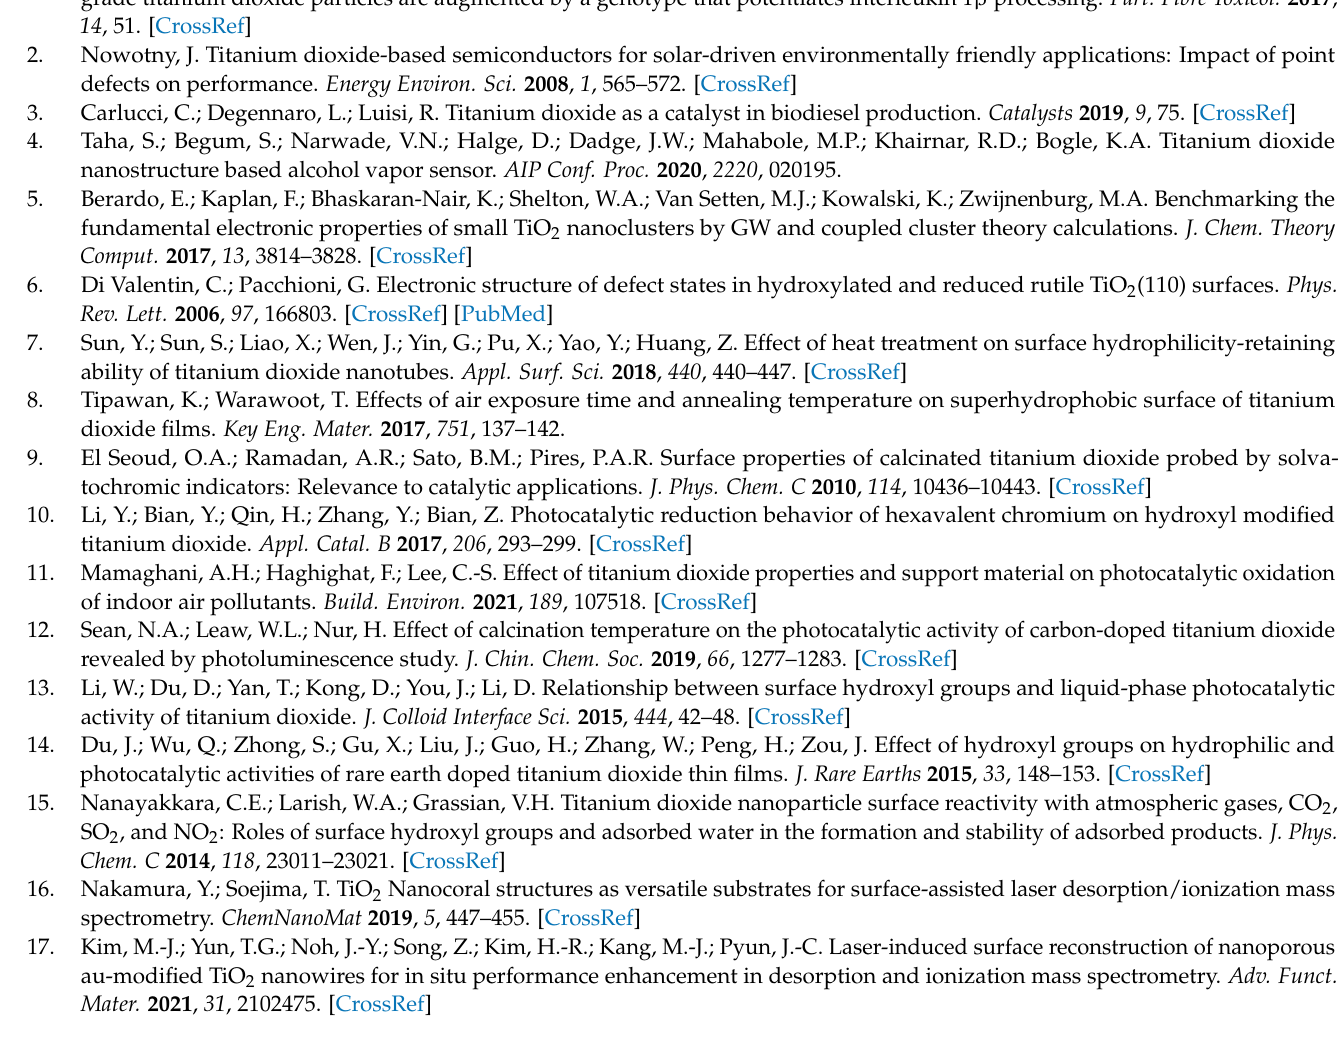
dye-modified samples. Figure S7: The TiO 2 − /(TiO 2 ) 3 OH − ratios obtained for heated TiO 2 samples, unmodified (P25 TiO 2 ) and dye-modified samples. Figure S8: LDI mass spectra of TiO 2 samples obtained in the positive ion mode. Figure S9: Exemplary LIFT mass spectra of (TiO 2 ) n − ions. Figure S10: Exemplary LIFT mass spectra of (TiO 2 ) n OH −